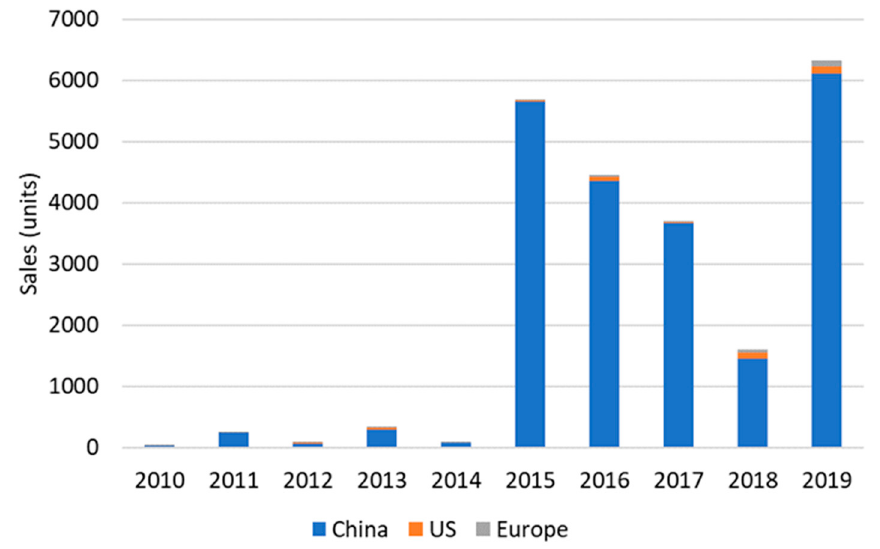
Figure 13. Global sales of e-trucks (Data source: [47]).